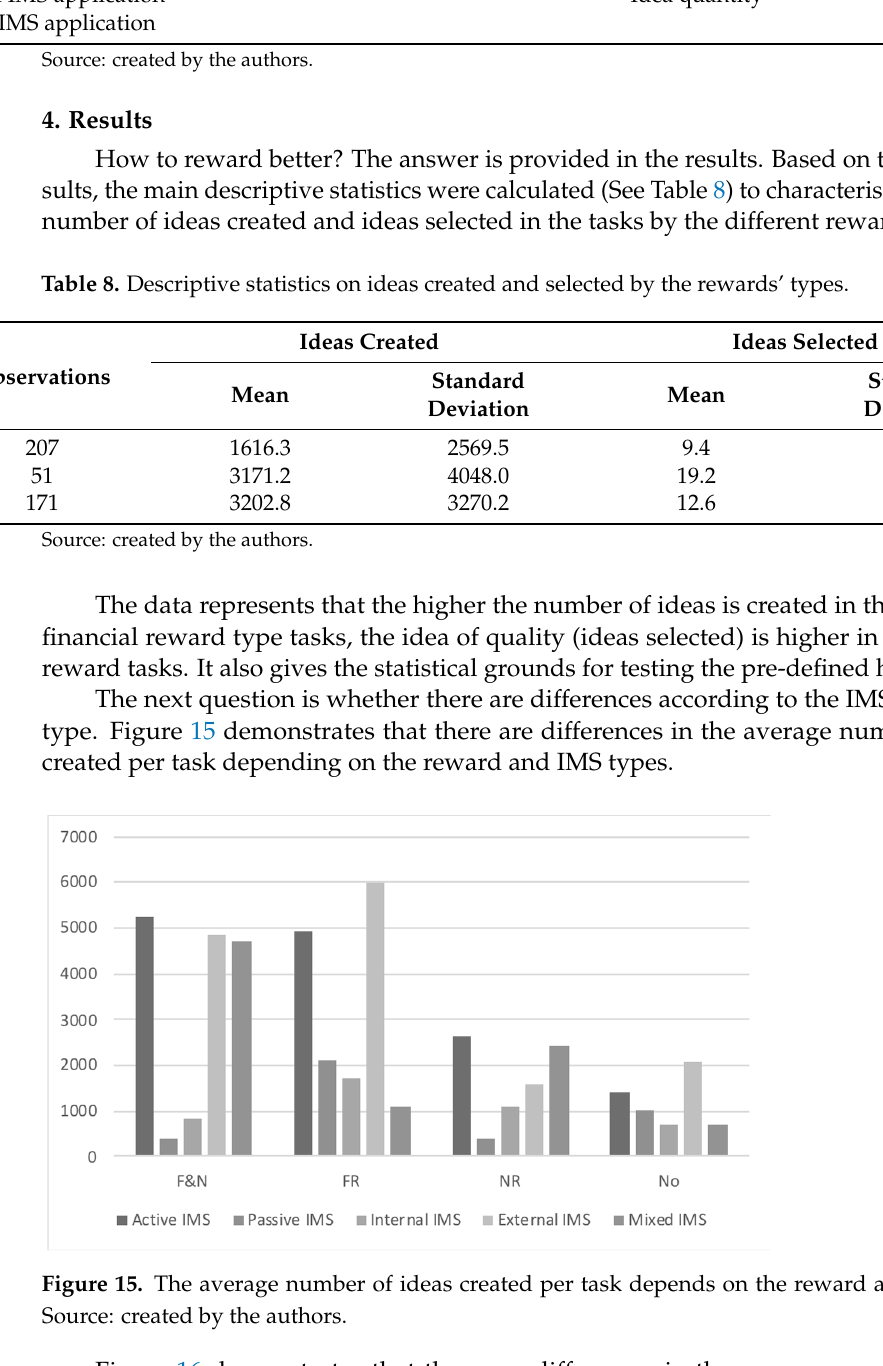
Figure 16. The average number of ideas selected per task, depending on the reward and IMS types. Source: created by the authors .